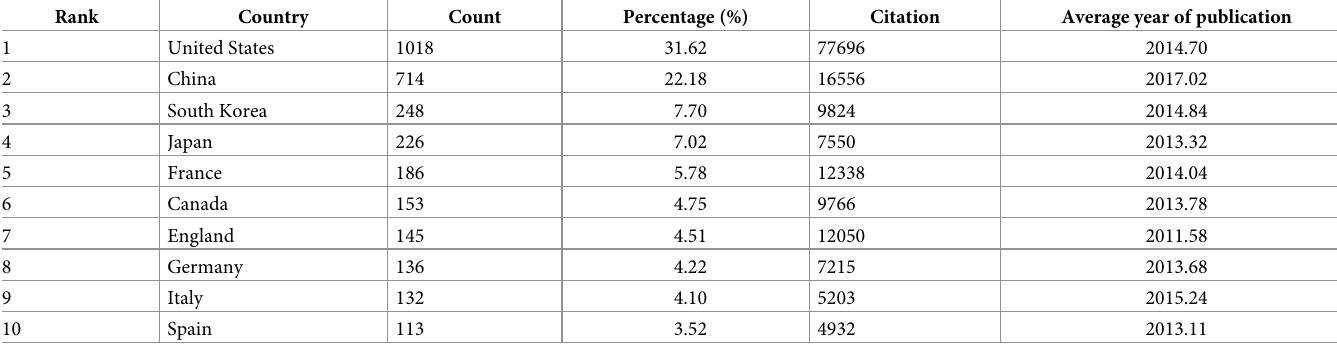
animal and human. The theme of cluster #3 (purple) can be summarized as LKB1 and related genes in tumor. The theme of cluster #4 (green) can be summarized as clinical trials about LKB1 and related genes mutations in tumors, especially in lung adenocarcinoma. The theme of cluster #5 (blue) can be summarized as co-mutated genes in tumors by gene sequencing. Table 1. Top 10 productive countries in LKB1 research, 2000 to